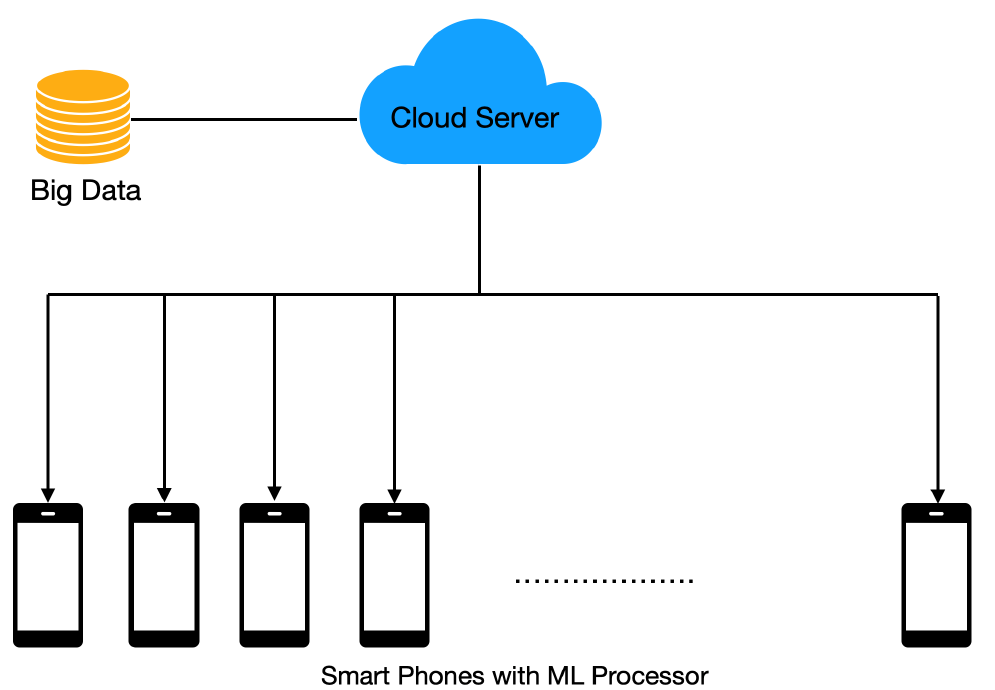
Figure 4. Proposed solution